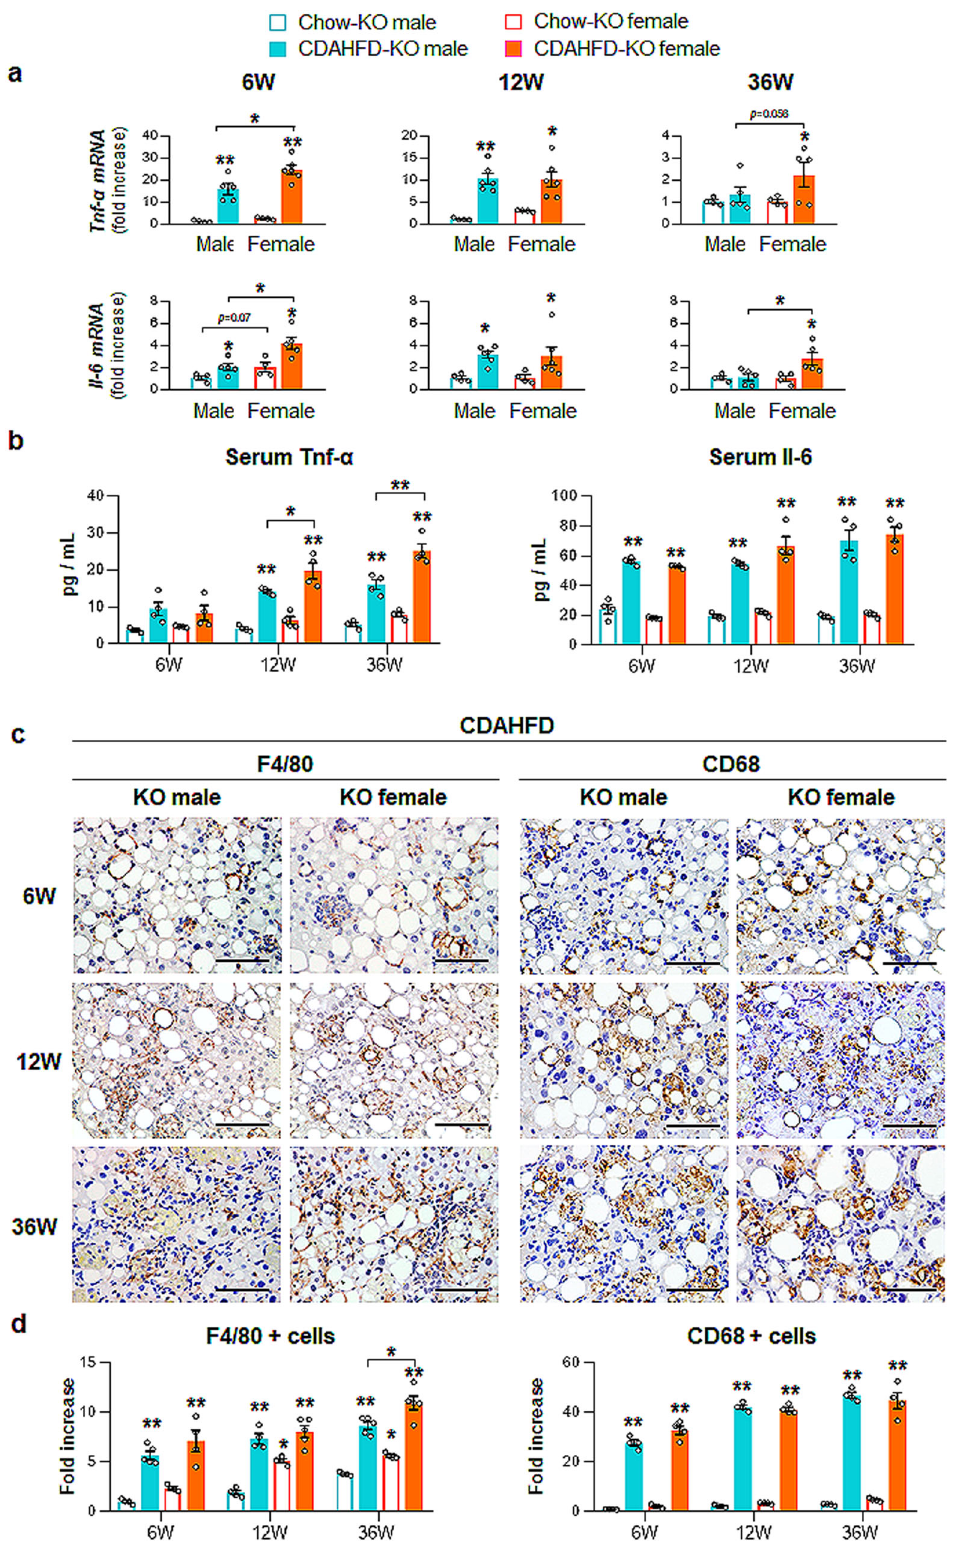
Fig. 6 Lack of Fpr2 elevates in fl ammation in female mice during CDAHFD feeding. a qRT-PCR analysis of in fl ammatory markers including Tumor necrosis factor-alpha (Tnf- α ) , Interleukin (Il-6) in KO male and female mice treated with chow or CDAHFD for 6, 12, and 36 weeks. b Levels of serum Tnf- α and Il-6 from these mice. All data represent the mean ± S.E.M. ( n ≥ 4/group, * p < 0.05, ** p < 0.005 vs own control). c Representative images of F4/80- or CD68- stained liver sections from these mice (Scale bar, 50 μ m). d Quantitative F4/80- or CD68-stained data from these mice. F4/80- or CD68- positive Kupffer cells were quanti fi ed by dividing the total numbers of positive cells by the total number of Kupffer cells. Data represent the mean ± S.E.M. ( n ≥ 4/group, * p < 0.05, ** p < 0.005 vs own control). Gray circles represent individual data points. See Supplementary Data for statistical